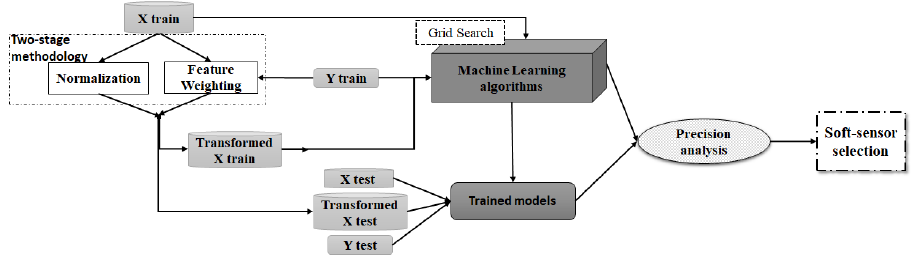
Figure 3. High-level diagram of the proposed autoML